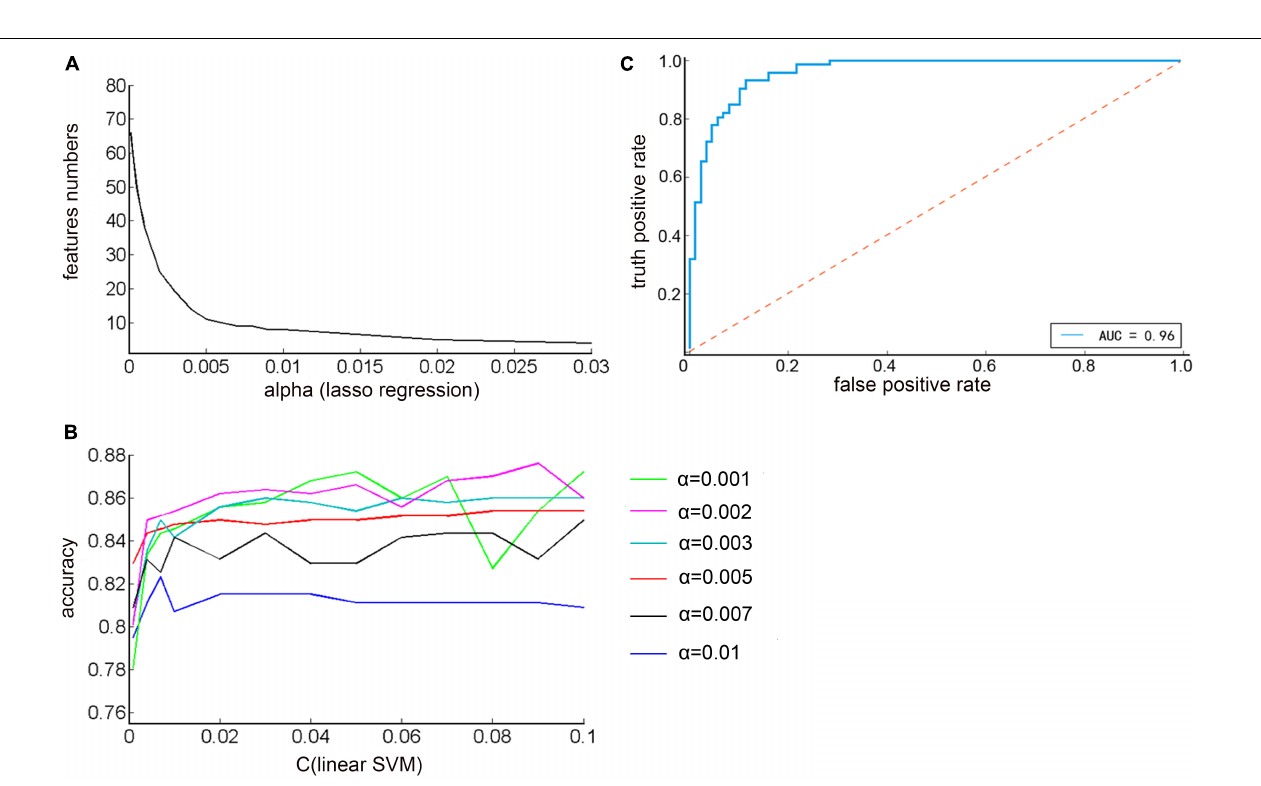
FIGURE 3 | Global brain activation of the group analysis. (A) Math shows a three-dimensional brain activation map in the math task. (B) Story shows a three-dimensional brain activation map in the story task. (C) Math vs. Story shows the difference of activated brain regions between the Math task relative to the Story task. (D) Story vs. Math shows the difference of activated brain regions between the Story task relative to the Math task. WM = working memory, IPS = Intraparietal sulcus, AC = Auditory cortex, SMA = Supplementary Motor Area.